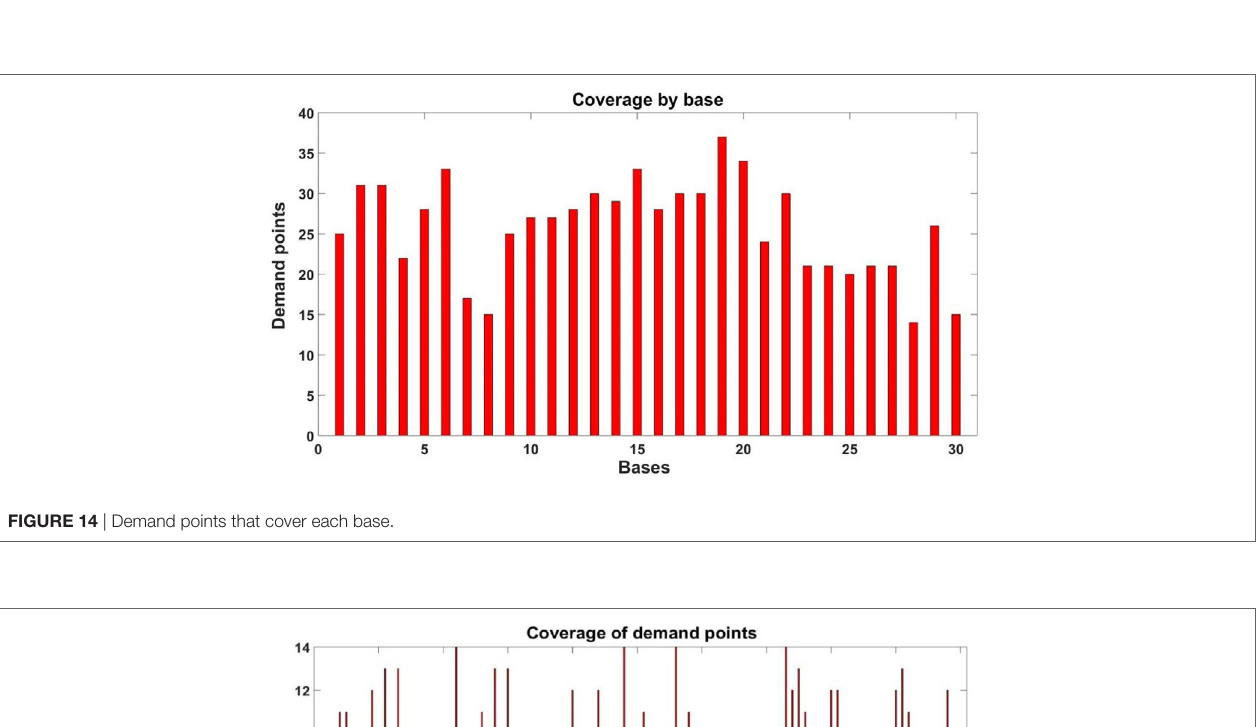
FigUre 13 | Number of demand points covered by each base, considering different possible fuzzy consequents (excellent, good, regular, and critical).